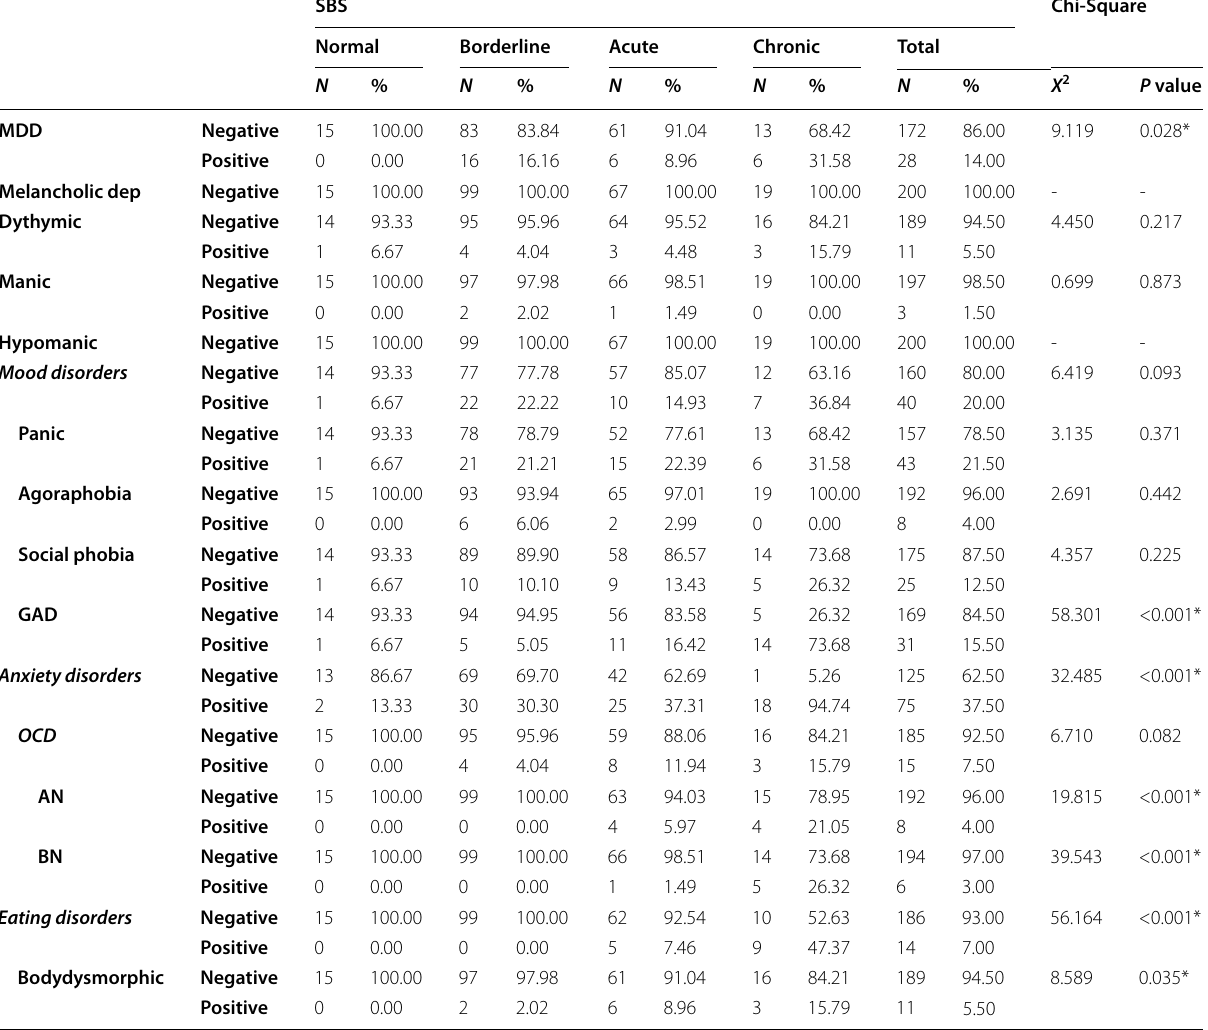
Table 5 Relationship between the prevalence of different psychiatric disorders and the prevalence of the selfie phenomenon